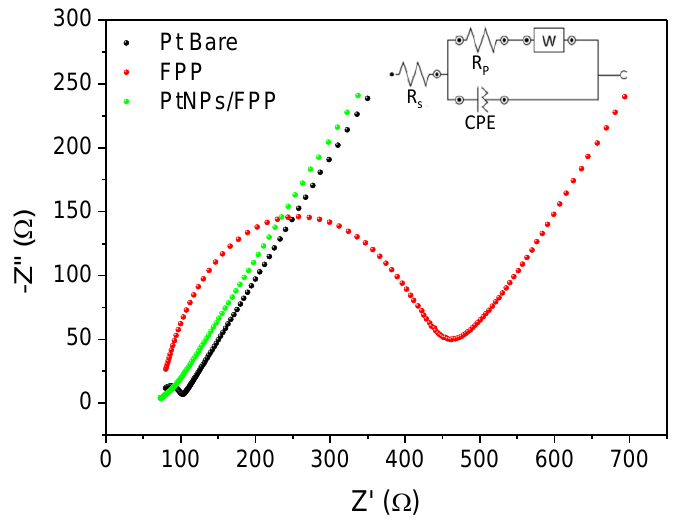
Figure 7. Nyquist plots of Pt bare, and FPP and PtNPs/FPP modified electrodes in a 10 mM K 4 [Fe(CN) 6 ]/K 3 [Fe(CN) 6 ] solution. Inset: Equivalent circuit obtained from fit and simulation of the EIS data ( χ 2 = 0.0044754; 0.0141 and 0.0027942 respectively). The experiment was repeated with at least five electrodes without significant differences. Table 3. EIS results for Pt bare, and FPP and PtNPs/FPP modified electrodes.